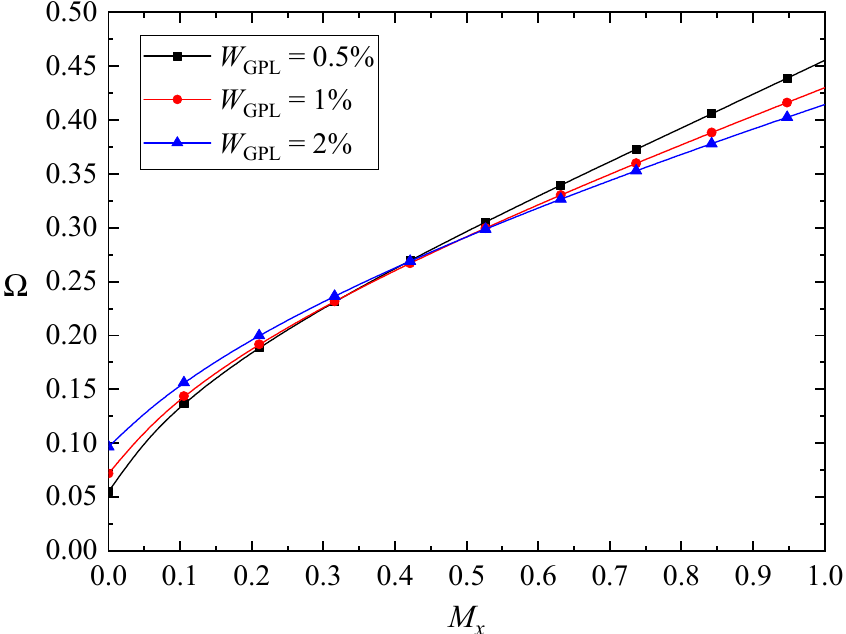
Ω Ω with the x -direction magnetic field ( λ = 1/10, K w with the x -direction magnetic field ( λ = 1/10, K w